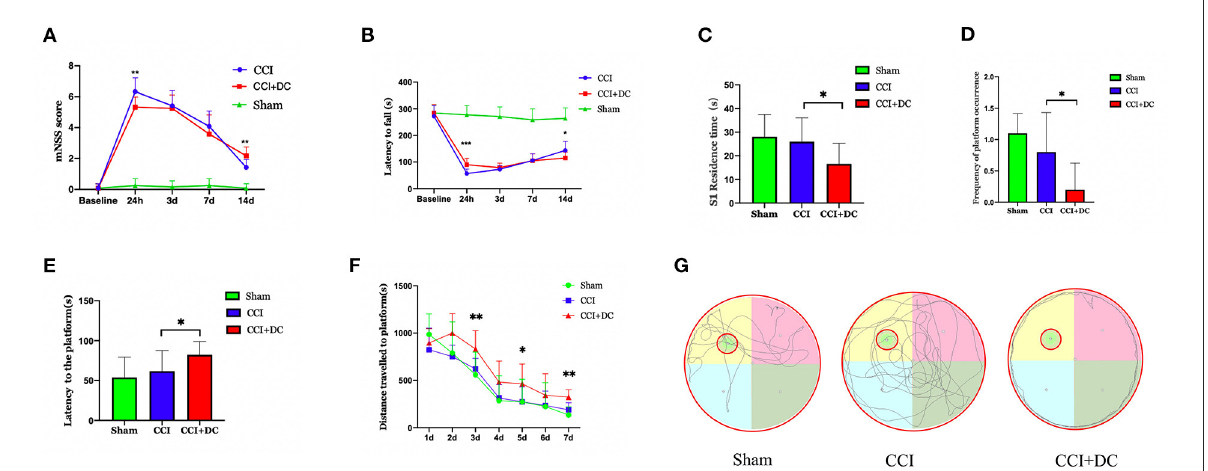
FIGURE4 Functional results. (A) Comparison of results among all groups indicated that mNSS score of mice in the CCI + DC group improved 24h after CCI compared with that in the CCI group, while functional score of mice in the CCI + DC group decreased significantly as time went by 14 days after CCI compared with that in the CCI group, and the difference was statistically significant. (B) The results of the rotarod indicated that the latency to fall in the CCI + DC group was significantly improved compared with that in the CCI group at 24h after CCI, and the difference was statistically significant. However, on the 14th day after CCI, the motor function of mice in the CCI + DC group was worse than that in the CCI group, and the difference was statistically significant. (C) MWM results indicated that on 7th day of the MWM experiment, the time for mice in the CCI + DC group to pass S1 quadrant. (D) The number of platforms were significantly lower than those in the CCI group, and the differences were statistically significant. (E) MWM results indicated that the platform latency of mice in the CCI + DC group was significantly higher than that in the CCI group, and the difference was statistically significant. (F) The total movement distance of mice was counted in the MWM experiment. It was found that the movement distance of mice in the CCI + DC group was longer than that of mice in the CCI group on day 3, 5, and 7 of the water maze experiment, and the difference was statistically significant. (G) Movement route of mice on day 7 between different group ( n = 10/group, * P < 0.05, ** P < 0.01, vs. CCI group).